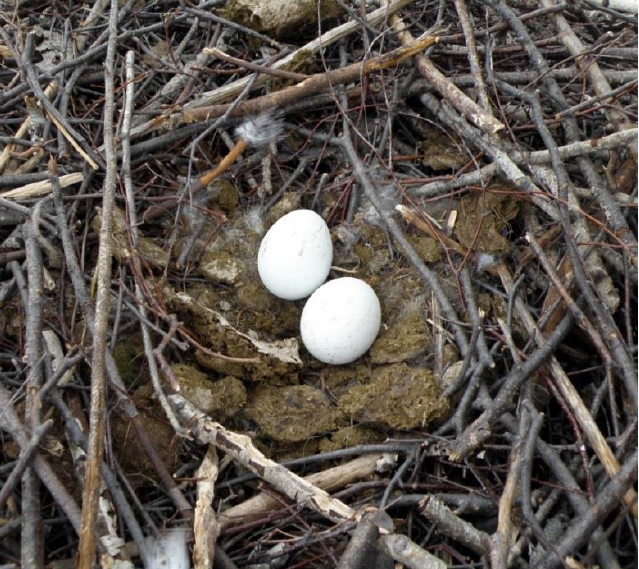
Рис. 5. Характерный признак гнезда могильника – выстилка из навоза. Алтайский край. 04 мая 2010. Фото Р.Ф.